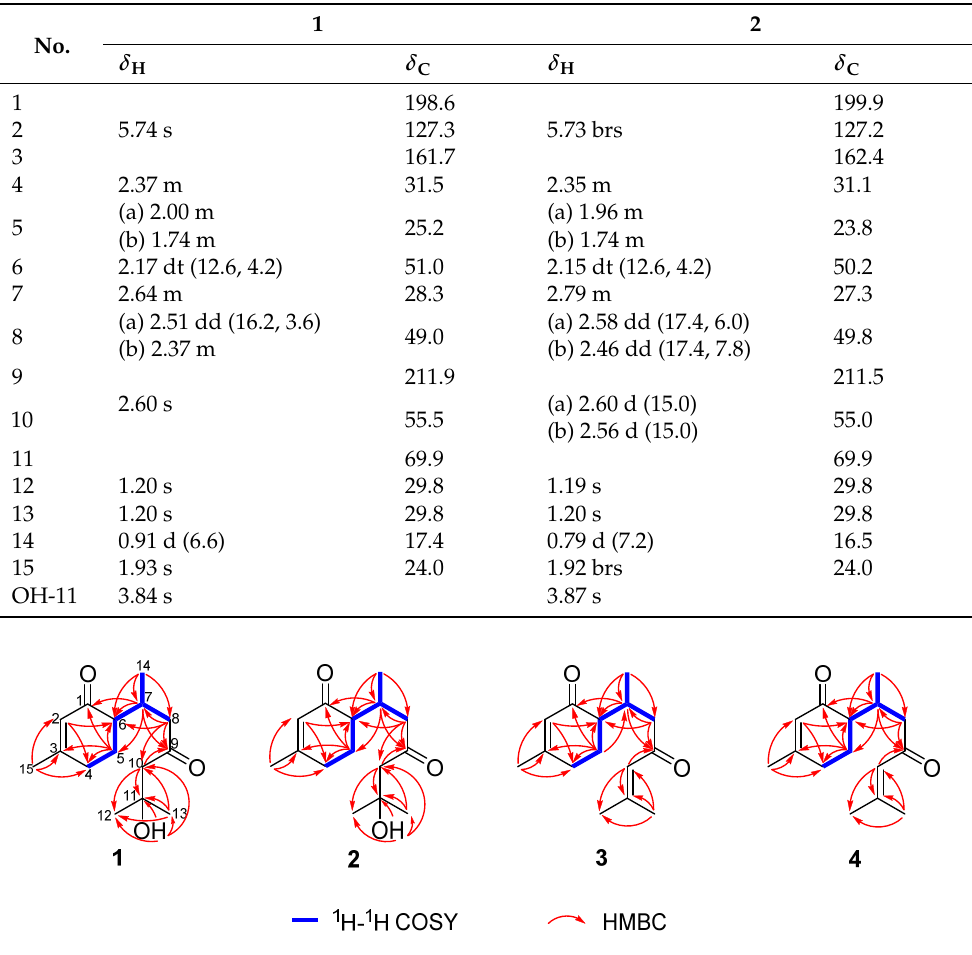
Figure 2. Key 1 H– 1 H COSY and HMBC correlations of compounds 1 – 4 . Curbisabolanone C ( 3 ) and Curbisabolanone D ( 4 ) were assigned the molecular Table 1. 1 H (600 MHz) and 13 C NMR (150 MHz) data for compounds 1 and 2 in acetone- d 6 ( δ in ppm, J in Hz).